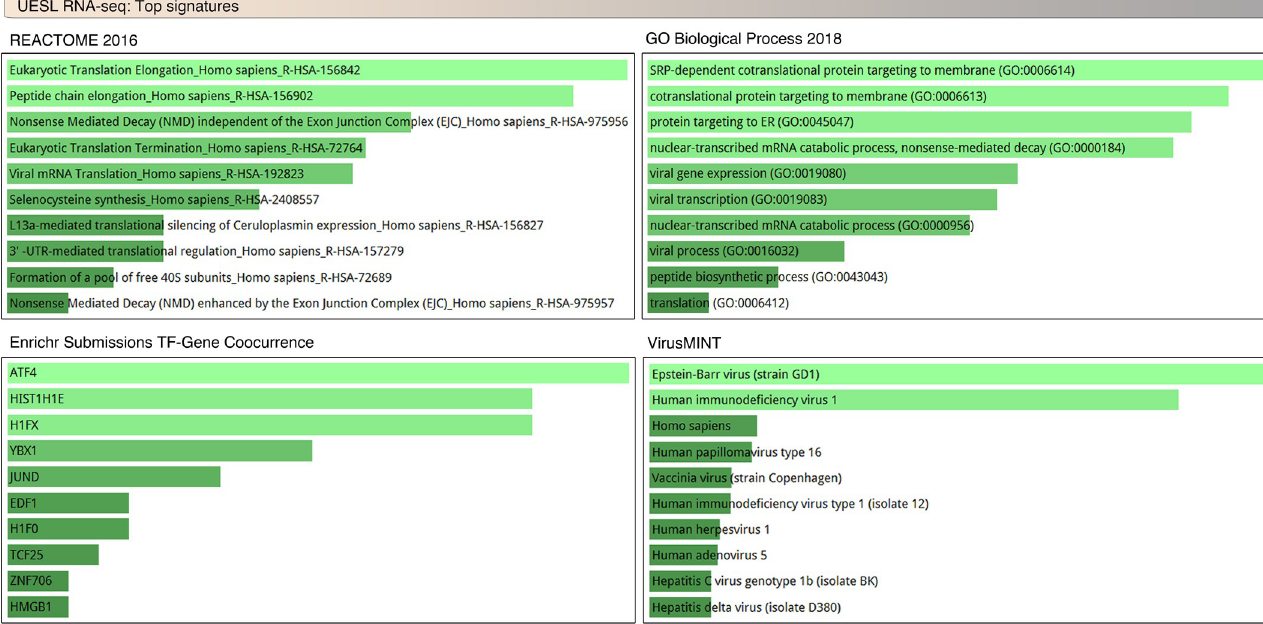
Fig 5. UESL display enriched expression of differentiation and viral response gene pathways. EnrichR analysis of RNA-seq TPM normalized genes of UESL samples. Notably, the most highly enriched gene pathways include transcription factors and epigenetic regulators that have been associated with regulation of cellular differentiation and/or viral response gene